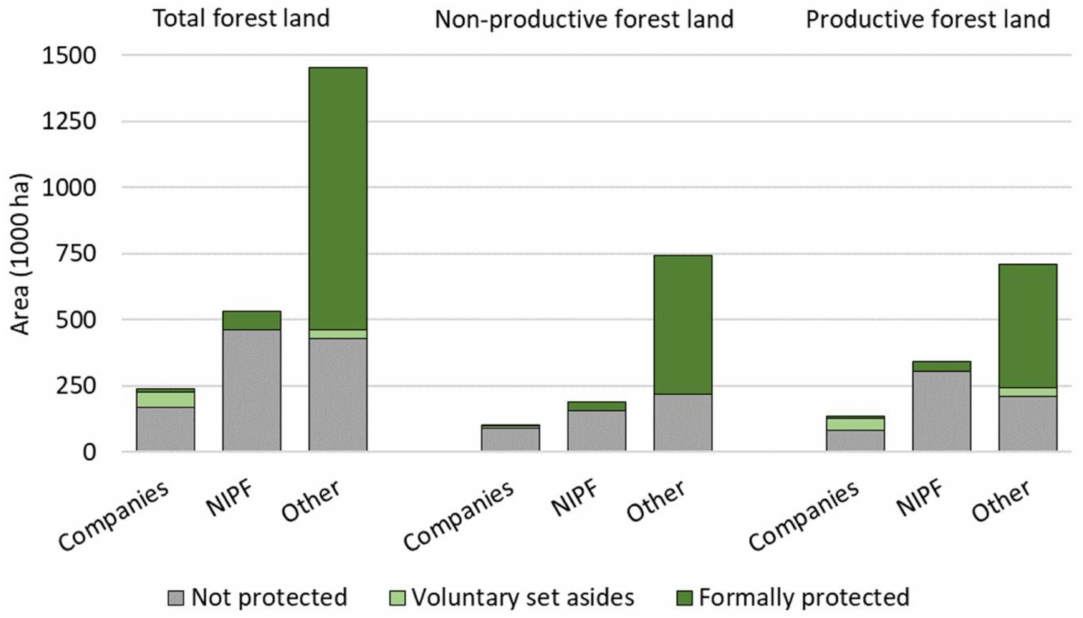
Figure 5. Distribution among land-owner categories of not protected, voluntary set aside and formally protected total forestland and productive forestland area for the region above the mountain forest border. Category “private companies” include stock-holding companies whereas category “NIPF” (non-industrial private forest landowners) does not. The category “other” combine public and collective ownership including the Sveaskog state forest company, the National Property Board, regional and municipal ownership, forest commons and other in-common forest estates, and church ownership. Data was extracted from the Swedish National Forest Inventory 2012–2016 (5 year